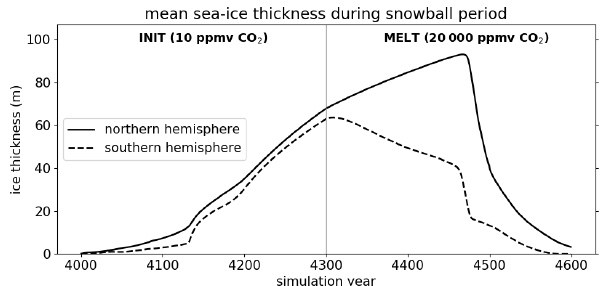
Figure 3. Evolution of the mean sea-ice thickness in the hemi- spheres during the snowball period. The vertical line denotes the transition from a low CO 2 concentration in INIT to a high CO 2 concentration in